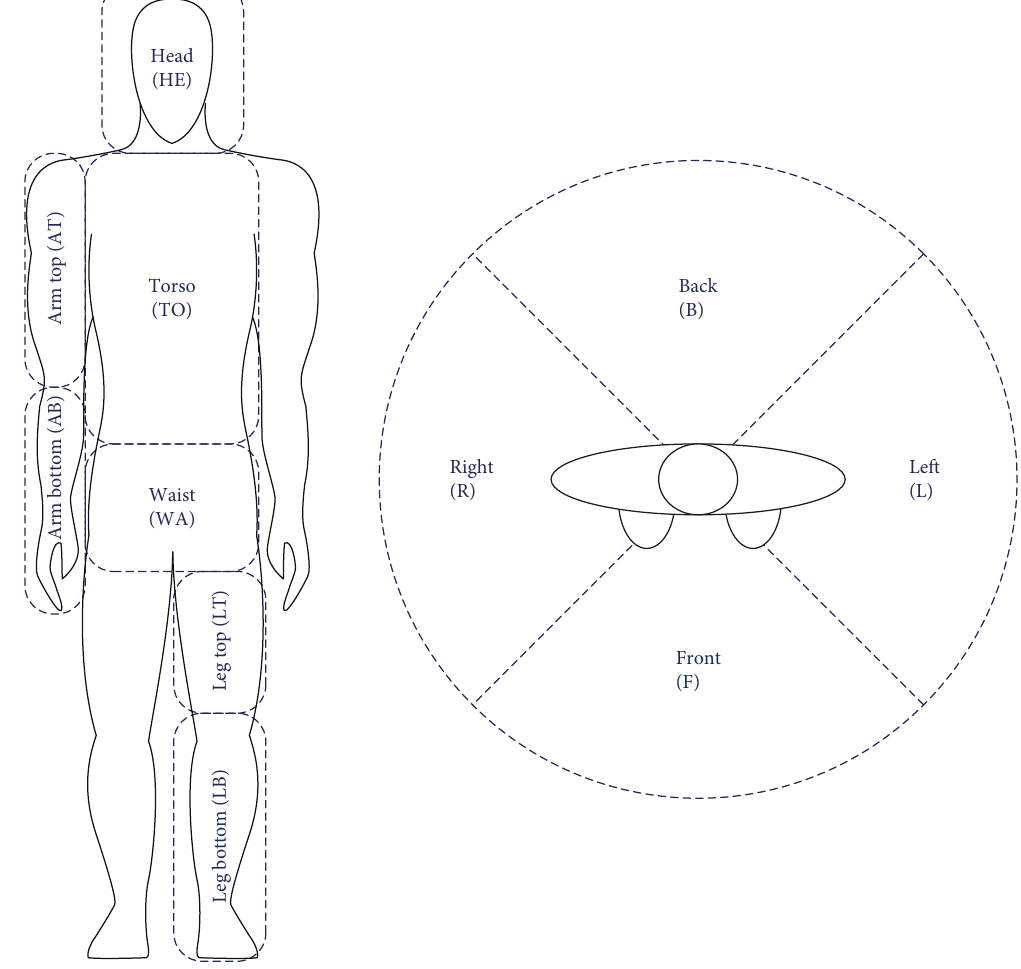
Figure 5: Segmentation and orientation of the human body proposed in